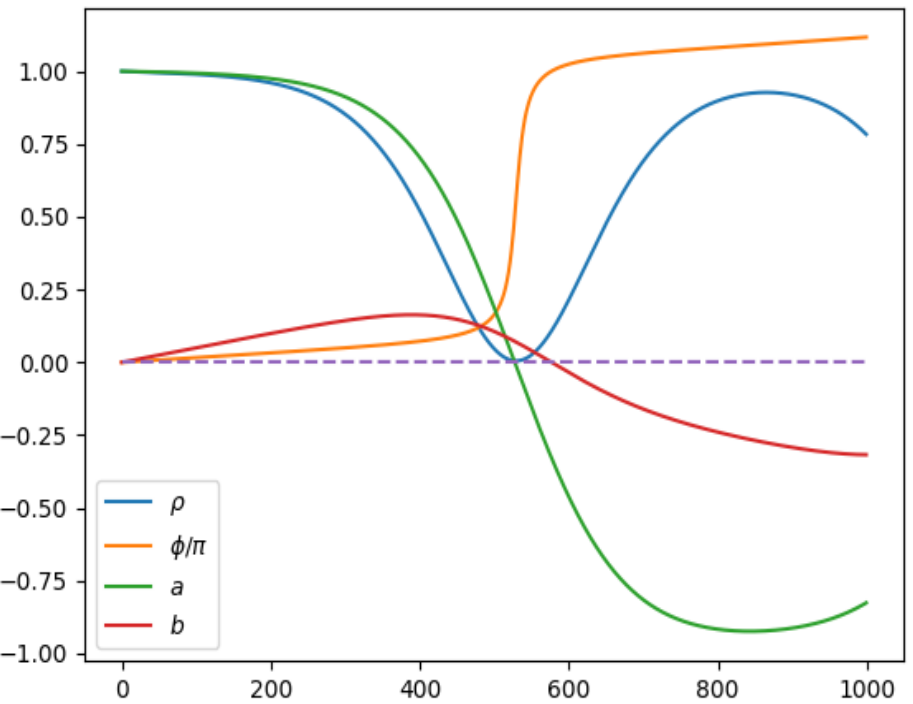
Figure A7. Typical result of a numerical solution with boundary conditions chosen on the left of the bridge ( u ( 0 ) = − 0.05, v ( 0 ) = 0.5). Range L = 1. The real and imaginary parts a and b of the wavefunction do not vanish at the same point, and therefore the absolute value ρ = | ψ | 2 = a 2 + b 2 is never exactly zero and the phase ϕ is always well-defined. This is a consequence of current conservation and implies that the GL equation does not predict any phase